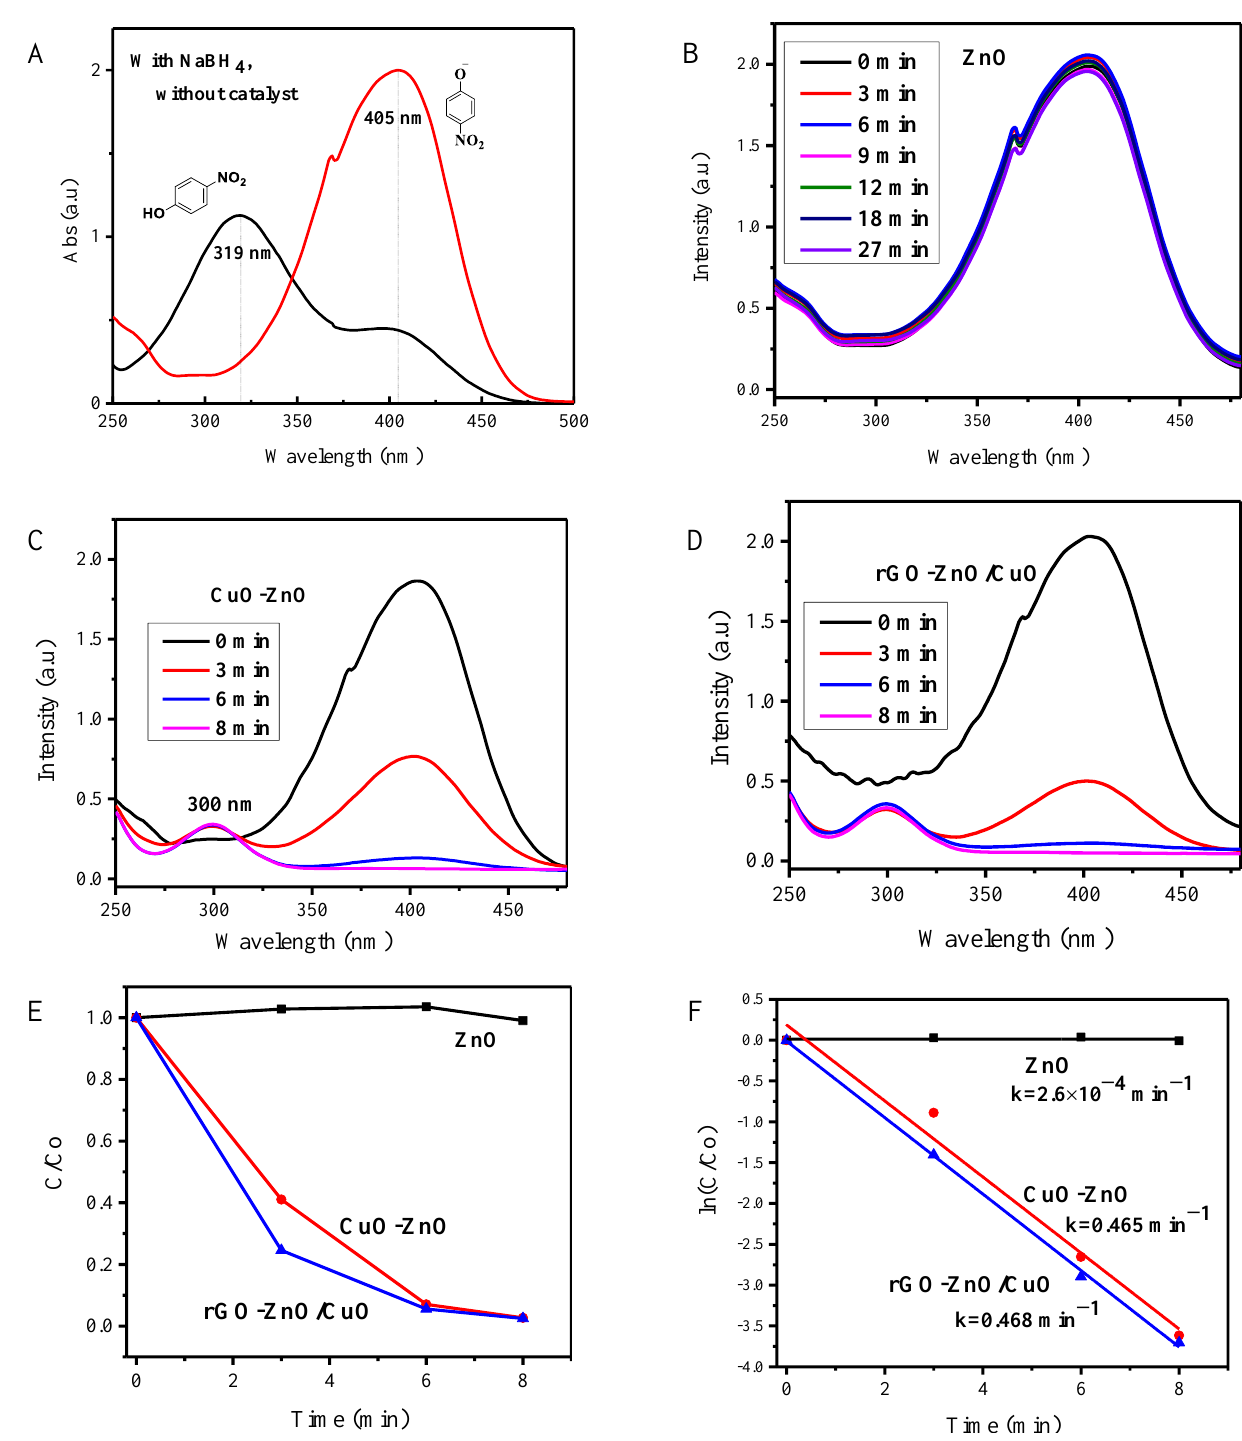
Figure 6. Photocatalytic degradation of MB using catalysts: ZnO NRs ( A ), CuO-ZnO NCs ( B ), and (rGO-ZnO)/CuO NCs ( C ); ( D ) plots of C t /C 0 vs. reaction time (min); ( E ) plots of ln(C t /C 0 ) vs. reaction time (min) for MB degradation using ZnO, CuO-ZnO, and (rGO-ZnO)/CuO NCs; ( F ) effect of scavengers on the photocatalytic degradation of MB using (rGO-ZnO)/CuO NCs.